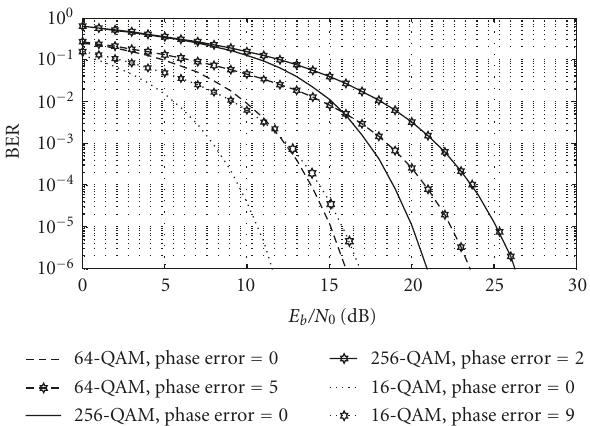
Figure 15: BER versus E b /N 0 for 16, 64, 256-QAM in permitted ranges of phase error. From left to right: 16-QAM: θ = 0,9 degrees, 64-QAM: θ = 0,5 degrees, 256-QAM: θ = 0,2 degrees.